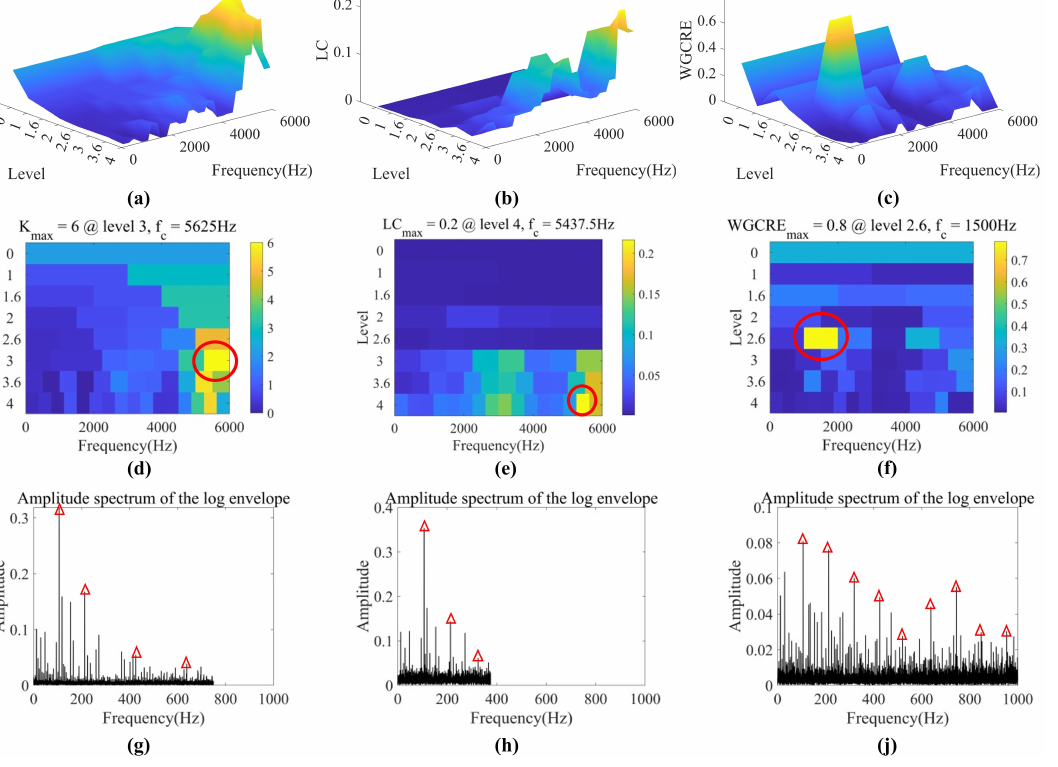
Figure 12. Optimal bands extraction of Case 1 (outer race fault). ( a – f ) are 3D and 2D FK, LC , and WGCRE –gram, respectively (optimal bands are circled in red). ( g – j ) are LES of FK, LC , and WGCRE , respectively (BPFOs with harmonics are marked with red triangles).